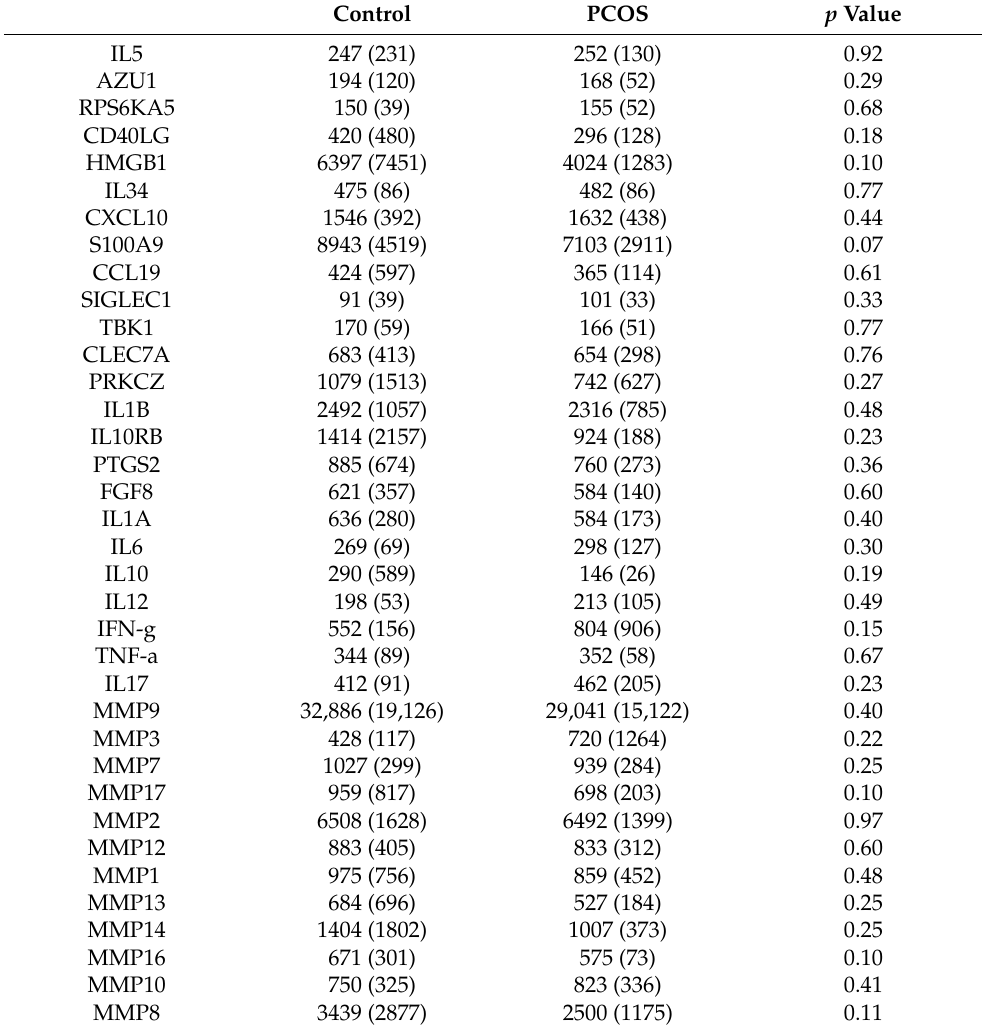
Table 2. Inflammatory protein levels in non-obese non-insulin resistant PCOS subjects and BMI- matched